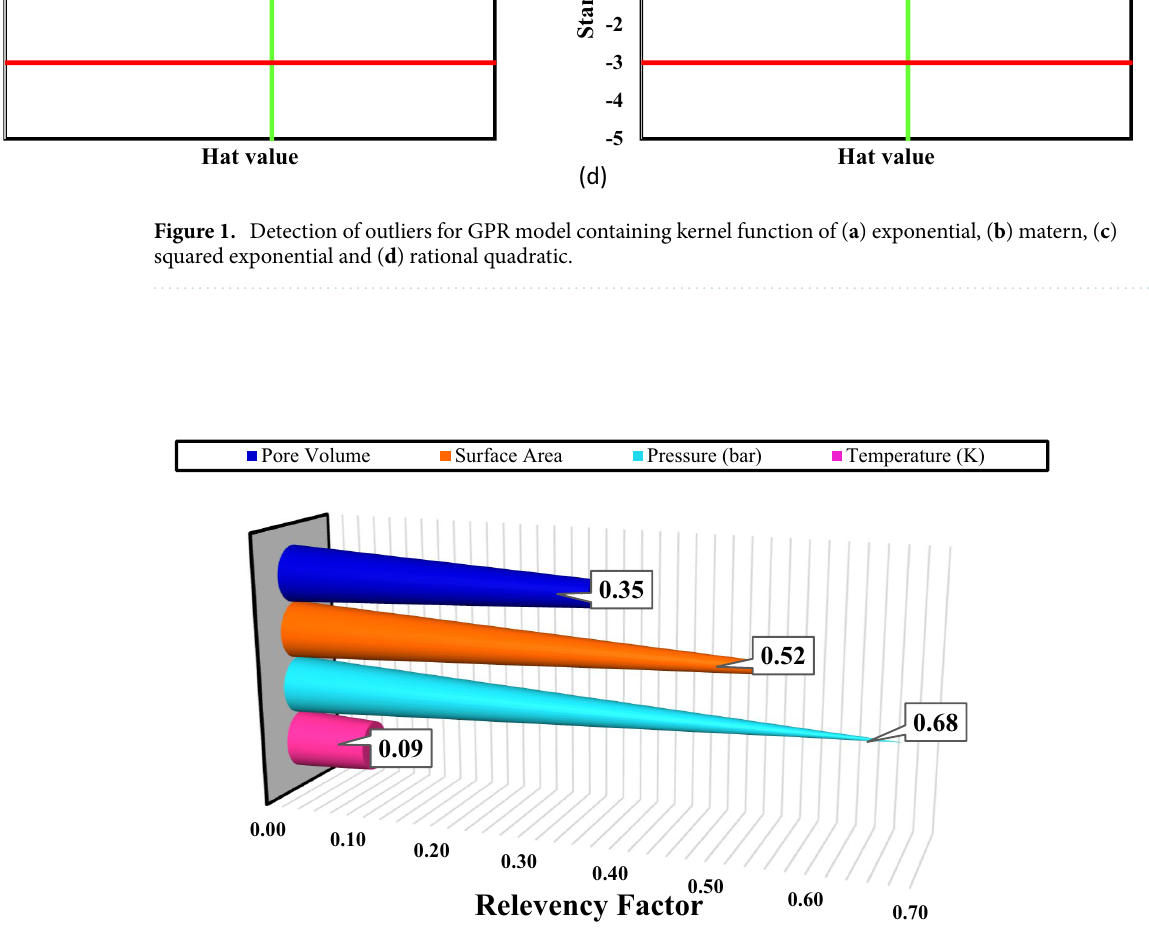
Figure 2. Analysis of sensitivity of the input parameters for CO 2 uptake by various